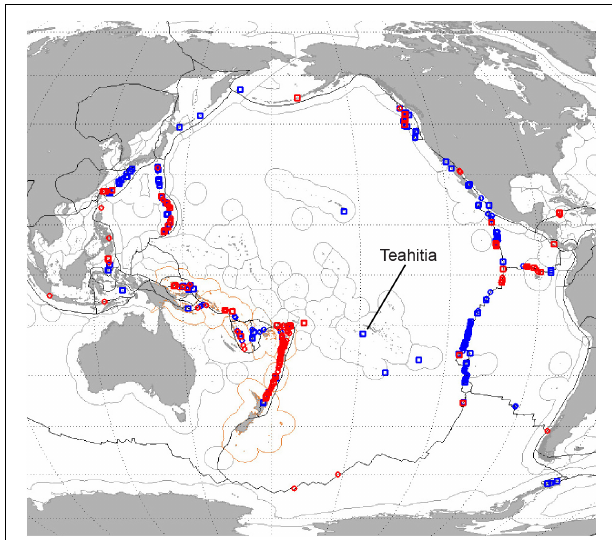
FIGURE 1 | Plot of all known locations of submarine hydrothermal venting in the Circum-Pacific as reported to the InterRidge Vents Data Base (Beaulieu et al., 2013). Red symbols denote sites located since 2000, while blue symbols denote sites already known at the turn of the millennium. The location of the Teahitia site is indicated, close to 17 ◦ 30 (cid:48) S, 148 ◦ 50 (cid:48) W.